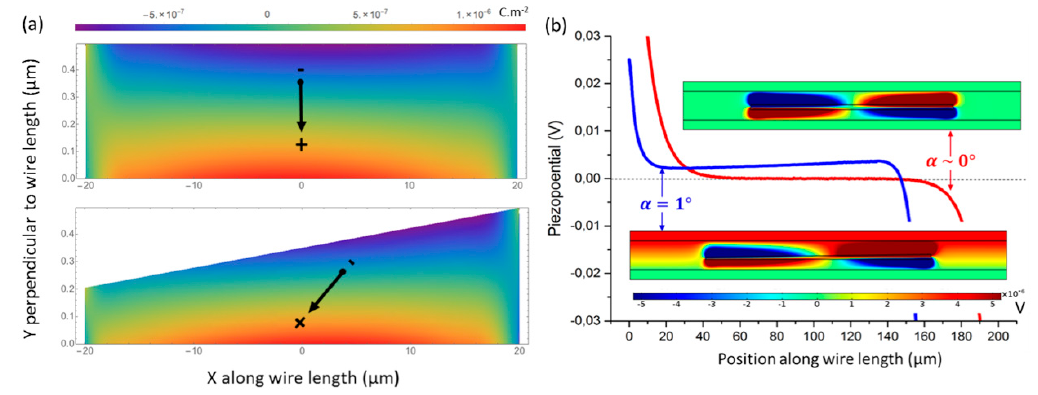
Figure 7. Two-dimensional finite element calculation of non-conical ( α = 0 ◦ ) and conical ( α = 1 ◦ ) embedded GaN wires bended under 10 cm radius curvature. ( a ) Piezoelectric charge density mappings (note the different scales along X and Y). ( b ) Piezo-potential taken at the top m-plane facet al.ong the length for (lines) and the corresponding cross-section mappings of the potential across the structure in insets.